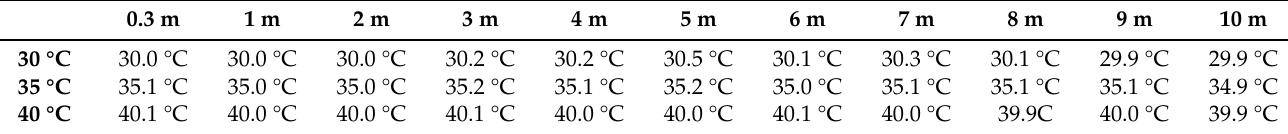
Table 6. The temperature estimation result from the proposed method.